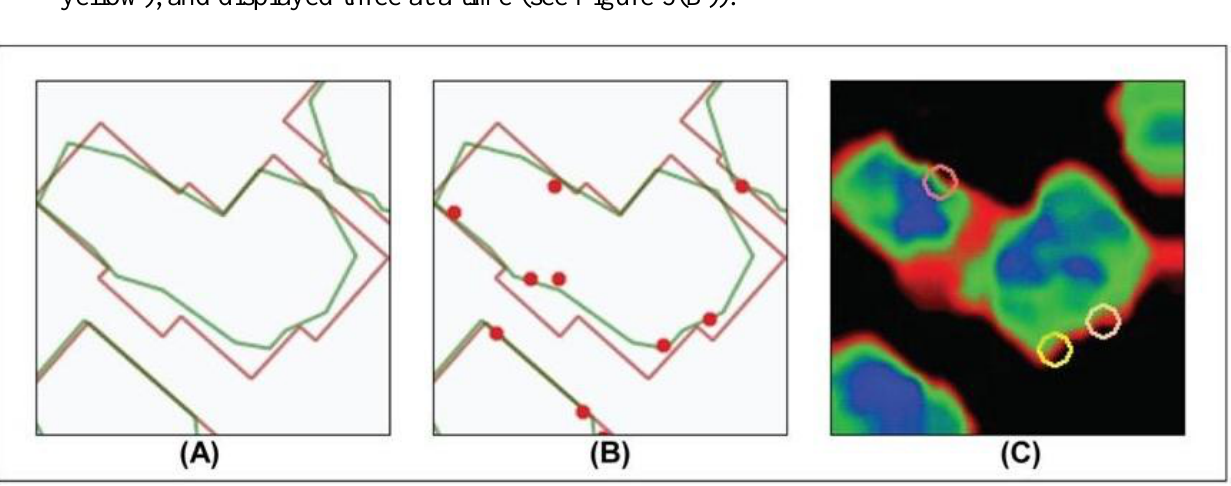
Figure 8. An example of (A) the fit between geobia (green) and cadastral (red) house objects, (B) their associated Hot Spots (red dots), and (C) how these Hot Spots appear on the thermal image. Hot Spot are thermally ranked from hottest to coldest (red, orange, yellow), and displayed three at a time (see Figure